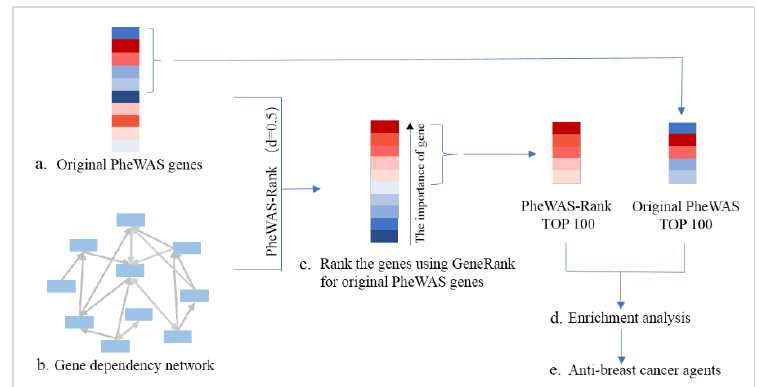
Figure 2. Pipeline of GeneRank-based anti-breast cancer drug discovery. Based on the 1742 PheWAS-identified breast cancer-related genes ( a ), we combined the gene-dependent network ( b ) to rank the original PheWAS data using the GeneRank algorithm ( c ). To cause the topology of the biological network and the original PheWAS to have the same weight, we set d = 0.5. Then, we performed a series of enrichment analyses on the original PheWAS (PheWAS-Rank gene set) and PheWAS-Rank top 100 genes (PheWAS-Rank gene set) ( d ). Finally, the agents that target the PheWAS-Rank gene set were predicted to be potential anti-breast cancer drugs ( e ).